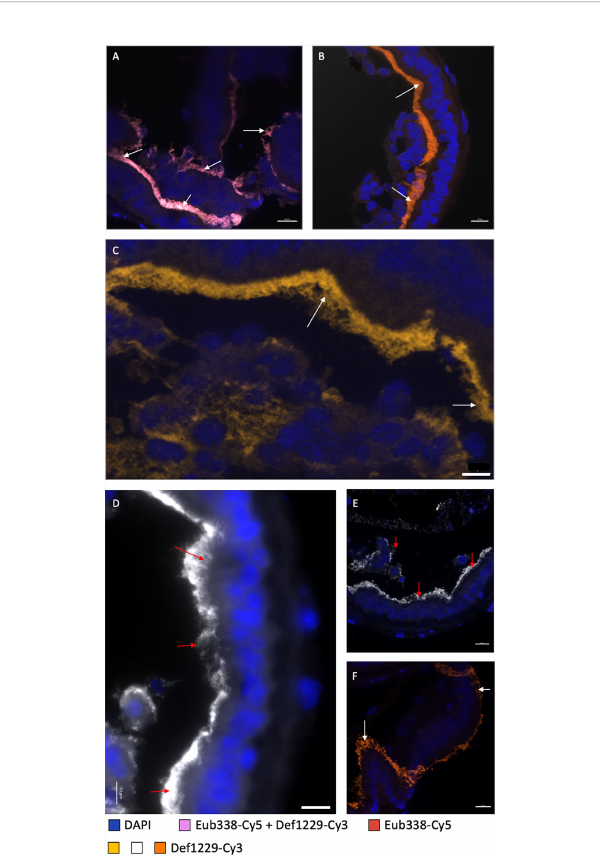
FIGURE 5 | Observation of Deferribacteres in different midgut tube sections of a R. exoculata and a R. chacei adults. (A – C) represent sections through the midgut tube of R. exoculata adult hybridized with Eub338-Cy5 (red)/ Def1229-Cy3 (white) (A) where double hybridization appeared in pink, or with Def1229-Cy3 (orange in (B) and yellow-brown in (C) . Tissue cell nuclei are labeled with DAPI (blue). Formamide concentration in hybridization buffer was 30%. Pictures in (A – C) were taken with Apotome ® , and with Z-stack and DIC for B only. (D – F) represent sections through the midgut tube of R. chacei adult hybridized with Def1229-Cy3 (white in (D, E) and orange in (F) . Tissue cell nuclei are labeled with DAPI (blue). Formamide concentration in hybridization buffer was 30%. White and red arrows are targeting some Deferribacteres observed on different part of the midgut tube. Pictures (E, F) were taken with Apotome ® . Scale bars (A – C, E, F) = 20 µm; Scale bar (D) = 10